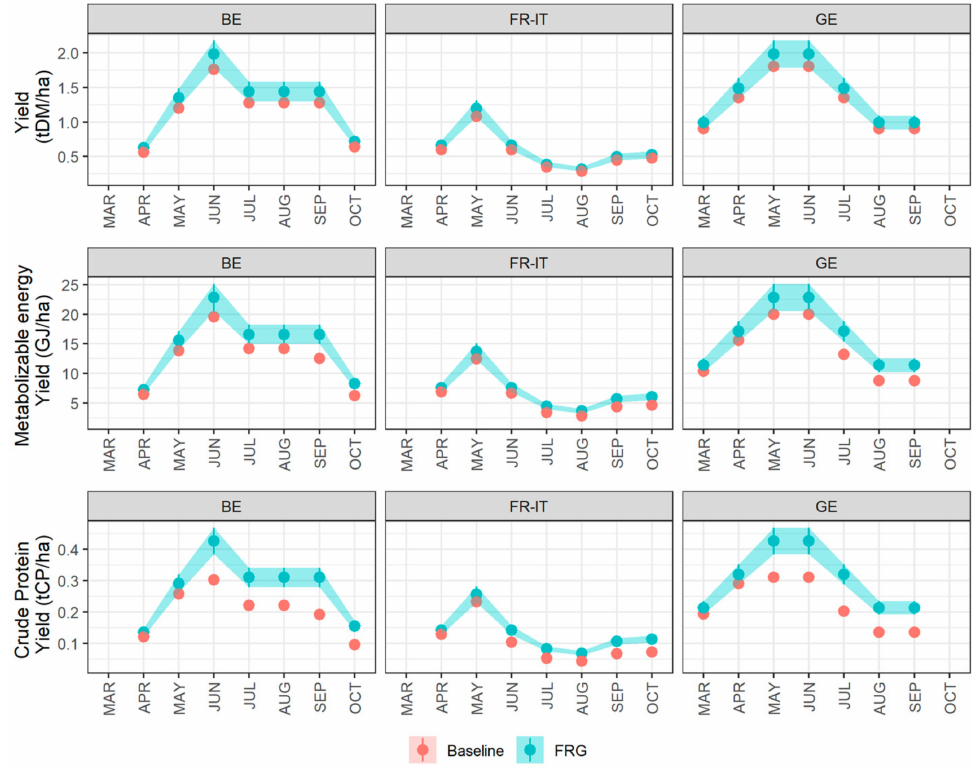
Figure 2. Dry matter, metabolizable energy and crude protein yield profiles for continuously (CG) and rotationally grazed (FRG) pastures in the three production